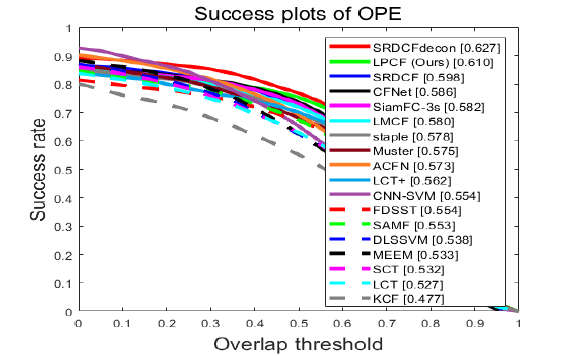
Figure 4. The success plots of OPE on OTB-2015. The numbers in the legend indicate the AUC scores. Our approach LPCF (marked as green square) shows its competitive performances against other state-of-the-art trackers with 61.0%